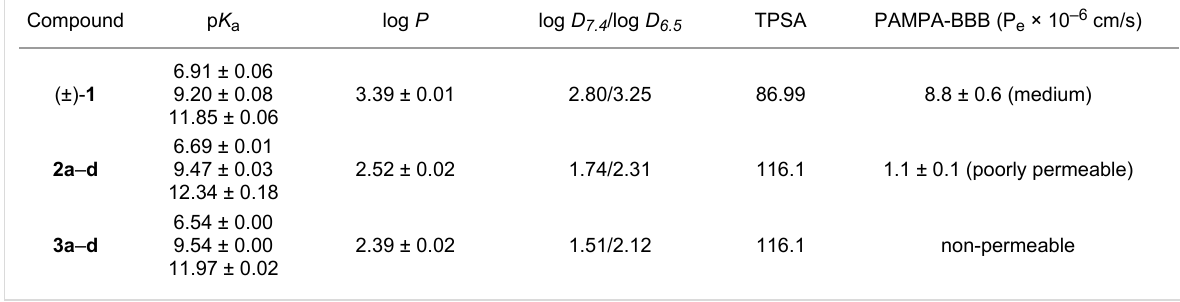
Table 1: Calculated and measured medicinal chemical parameters of dracocephins A and B compared to those of naringenin. Compound